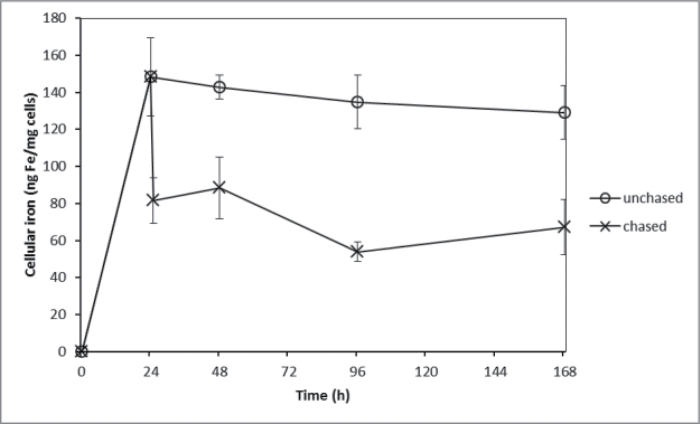
Total E. siliculosus cellular iron 55Fe uptake (i.e. not washed with the Ti reagent) as a function of time by E. siliculosus treated with 30 μM 55FeEDTA or following a chase of 30 μM 56FeEDTA. The chase was added at the 24-h time point. Data are mean ± standard deviation of triplicate measurements.